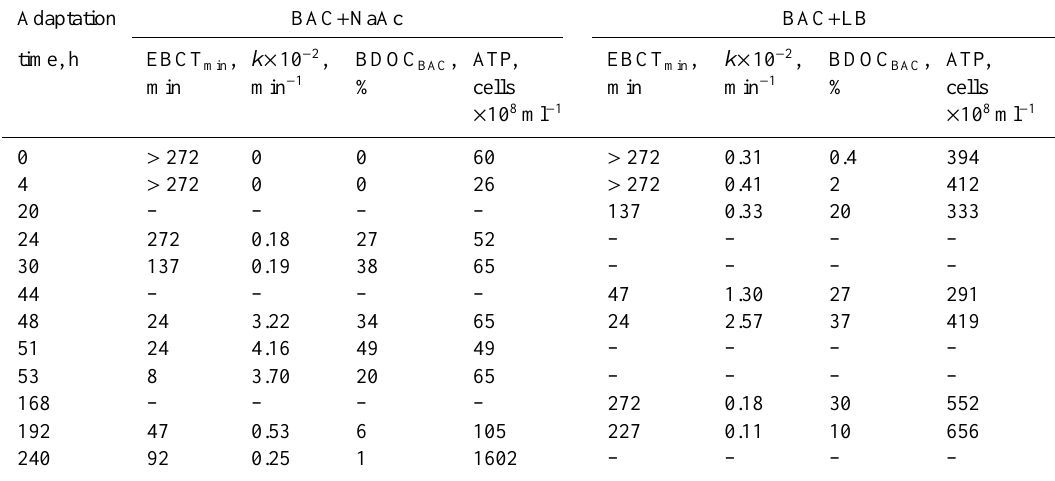
Table 1. Biodegradation of substrate in glass column system feed using water samples supplemented with labile organic carbon depending on the adaptation time of the experimental system.